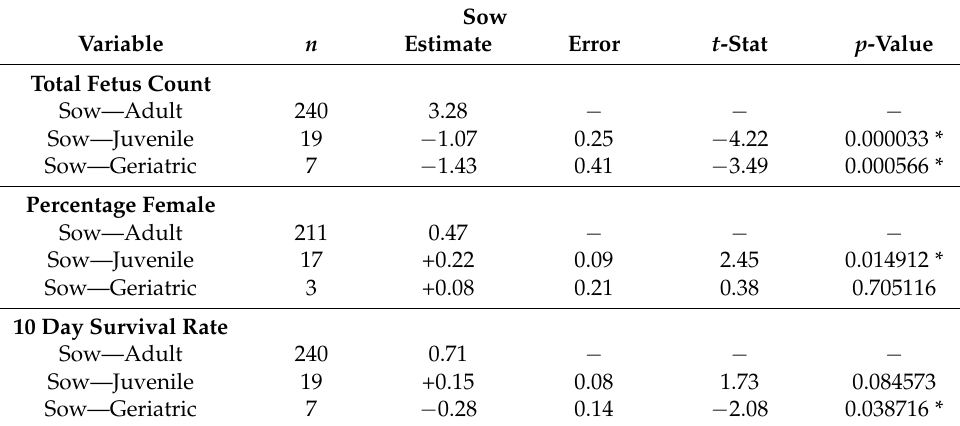
Table 3. Analysis of effect of strain 13/N guinea pig sow age at delivery on breeding outcomes. ANOVA was used to analyze differences in mean total fetus count, percentage of female pups in the litter, and pup survival rate after 10 days for juvenile or geriatric guinea pigs, as compared to adult guinea pigs (t-Stat and p -value set as intercept). Age is based on the age of the parental sow at pup delivery. Sow